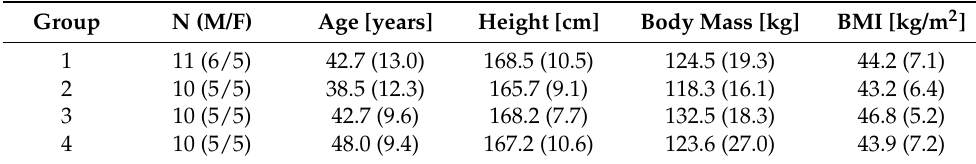
Table 1. Number of males or females, age, height, body mass and BMI in the four groups are reported. Group